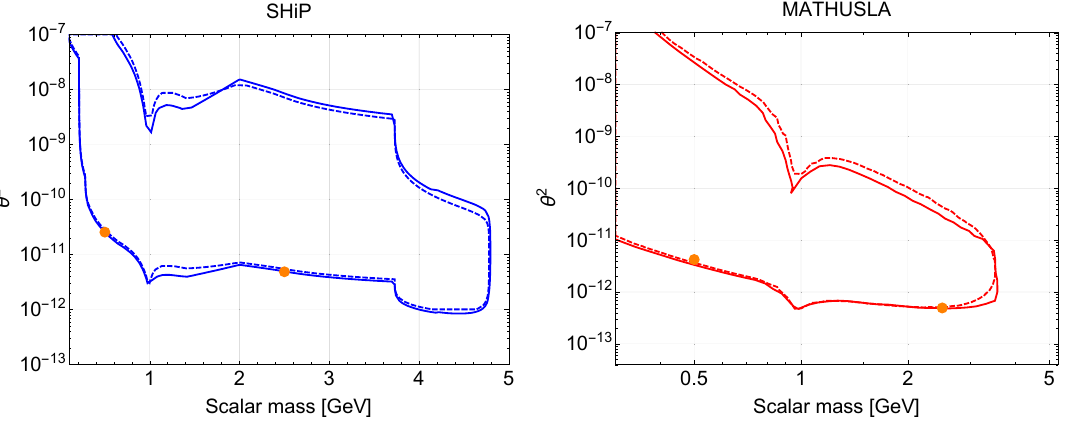
Figure 11 . Sensitivity to the scalar portal particles for the SHiP ( left panel ) and MATHUSLA ( right panel ) experiments. Solid lines — results obtained in this work. Dashed lines — simulations of SHiP [1] (left panel) and MATHUSLA [19] (right panel). In order to facilitate the comparison with collaboration results we have used different scalar production and decay models in left and right panels: for comparison with MATHUSLA results we took the model from [19], while for comparison with SHiP we used the model from [29], see section 7.2. Orange points, based on analytic estimates of the lower boundary, allow for simple cross-check of our results, see appendix